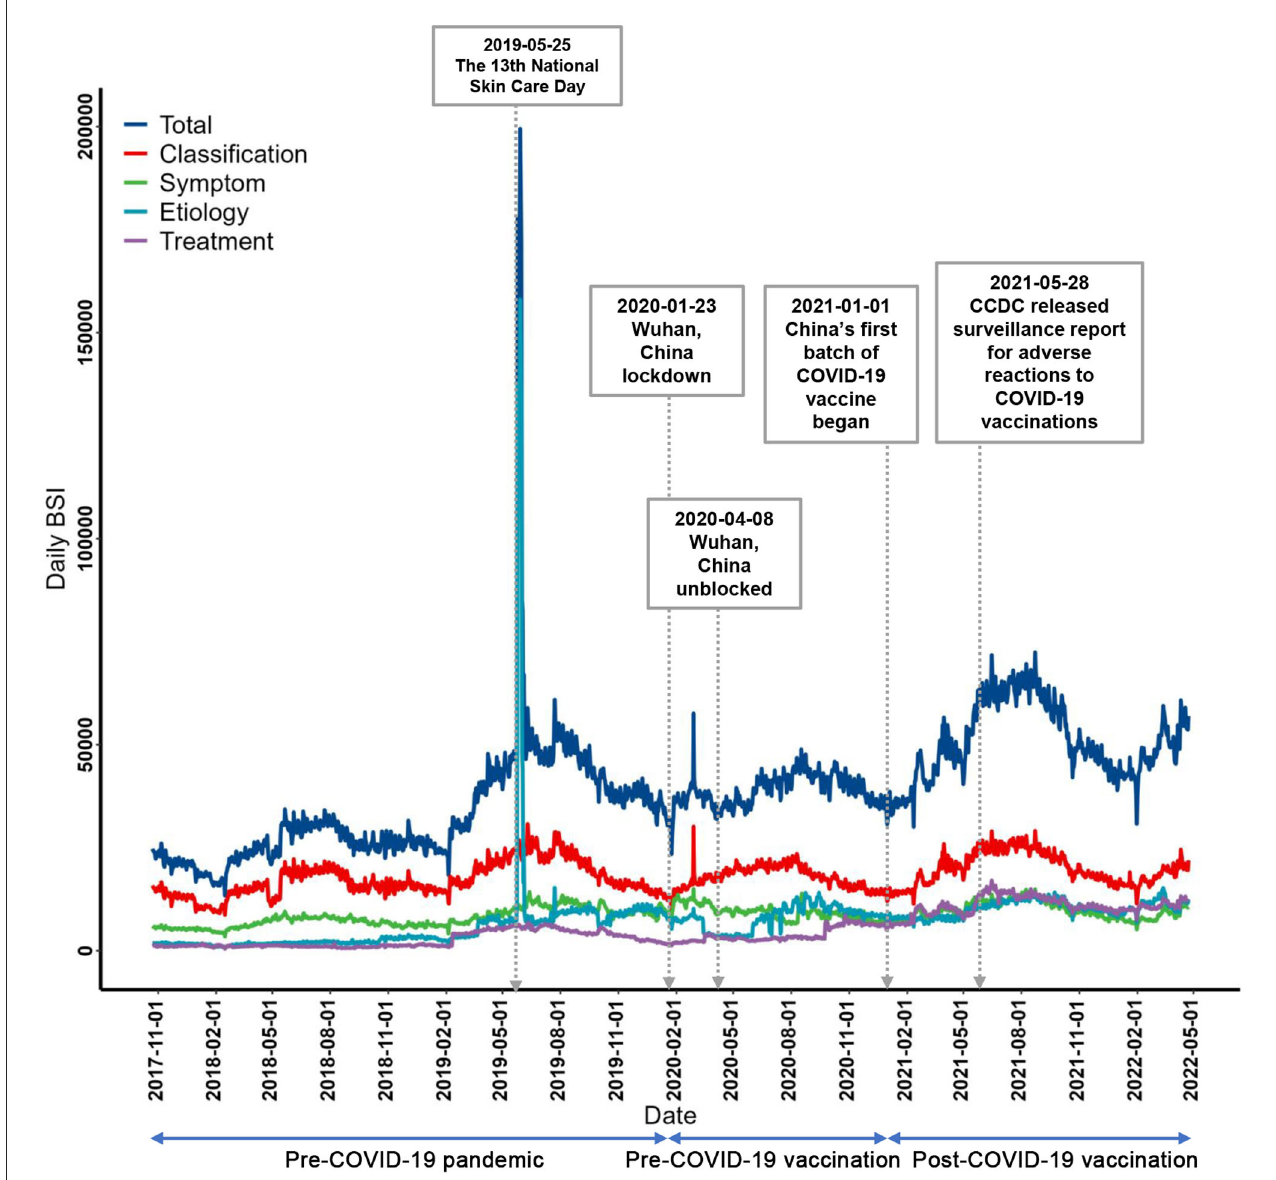
FIGURE2 Daily BSIs comparison in urticaria search themes (including the total search) from October 23, 2017 to April 23,